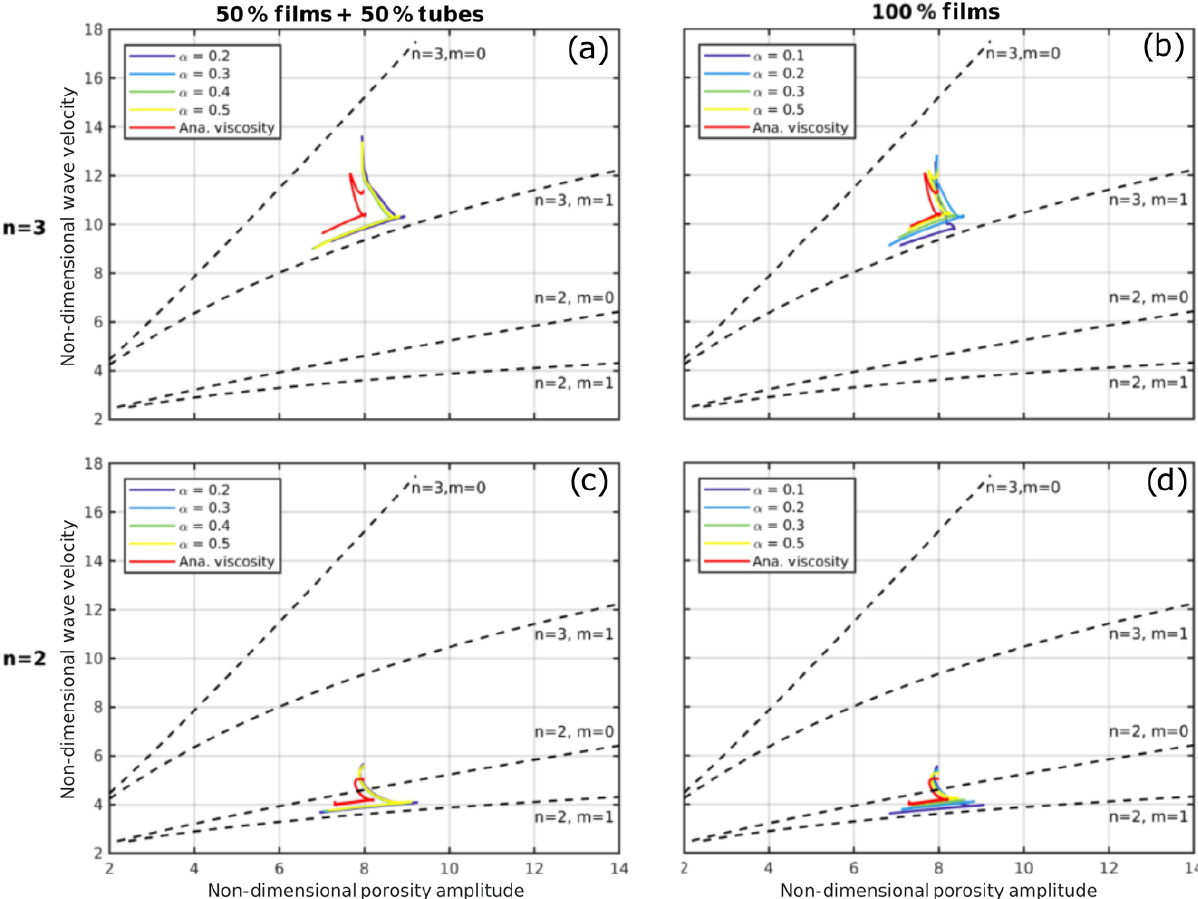
Figure 5. Dispersion curves of solitary waves with (a) n = 3, films and tubes; (b) n = 3, films; (c) n = 2, films and tubes; and (d) n = 2, films for different aspect